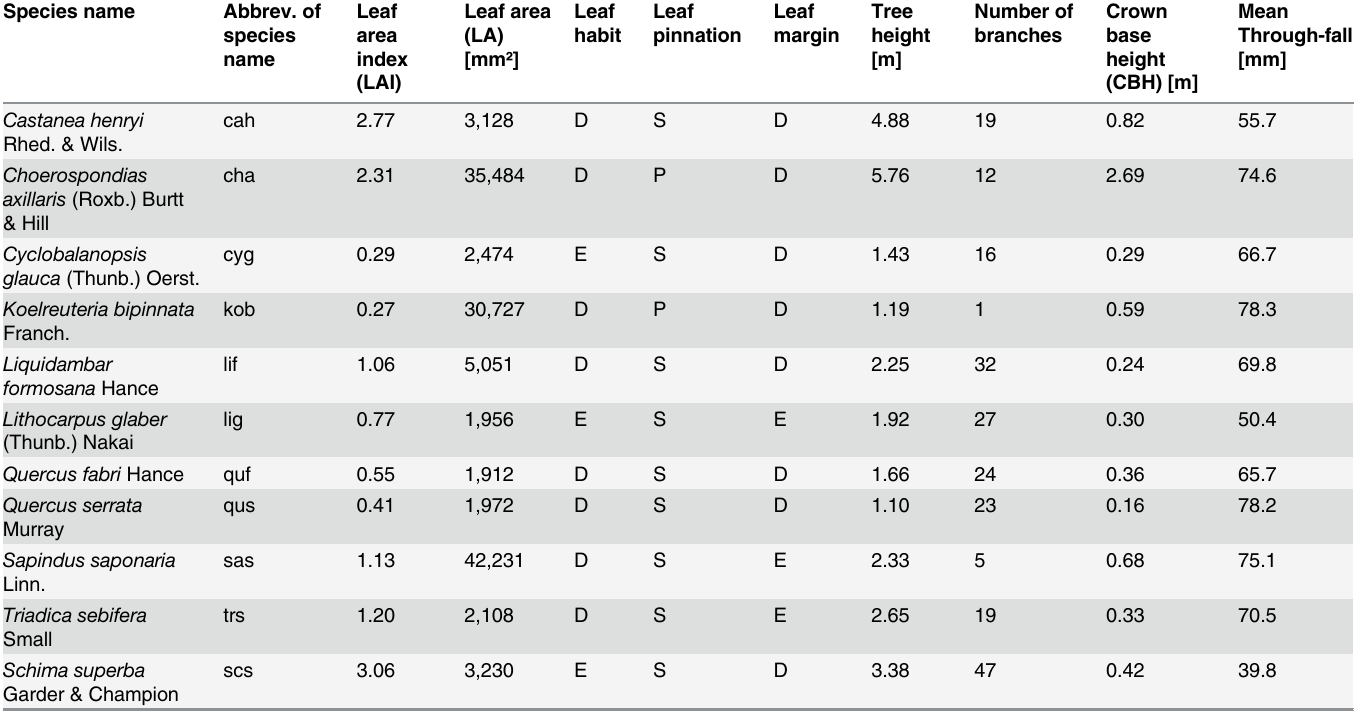
Values represent means of the variables measured. Abbreviations: D = deciduous, E = evergreen, S = simple, P = pinnate, D = dentate, E = entire. Mean throughfall refers to the mean across all rainfall